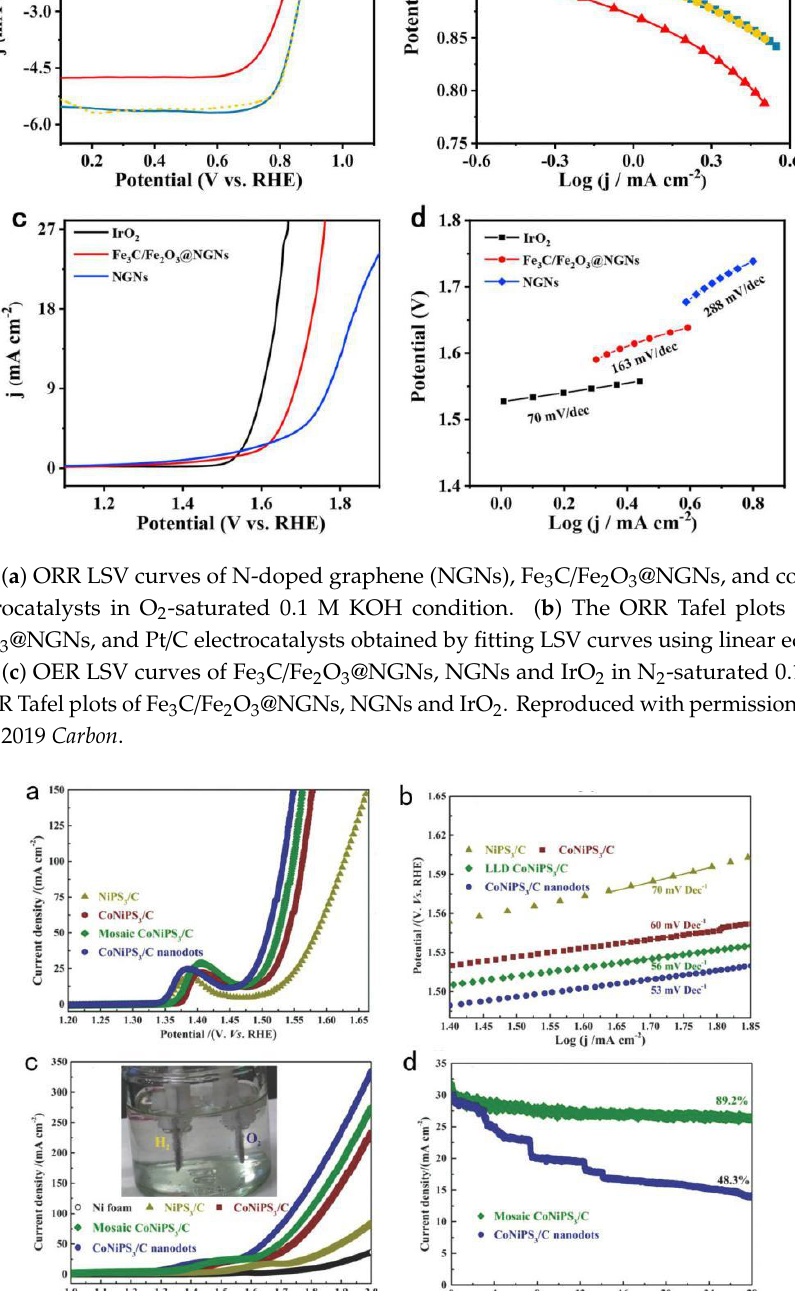
Figure 16. ( a ) OER curves, ( b ) Tafel plots, and ( c ) polarization curves of NiPS 3 / C, CoNiPS 3 / C, and the mosaic CoNiPS 3 / C nanosheets and nanodots. The inset image in ( c ) shows the mosaic CoNiPS 3 / C nanosheets used in water electrolysis. ( d ) Chronoamperometric curves of nanosheets and nanodots of CoNiPS 3 / C. Reproduced with permission from [42]. Copyright 2018 Advanced Functional Materials .